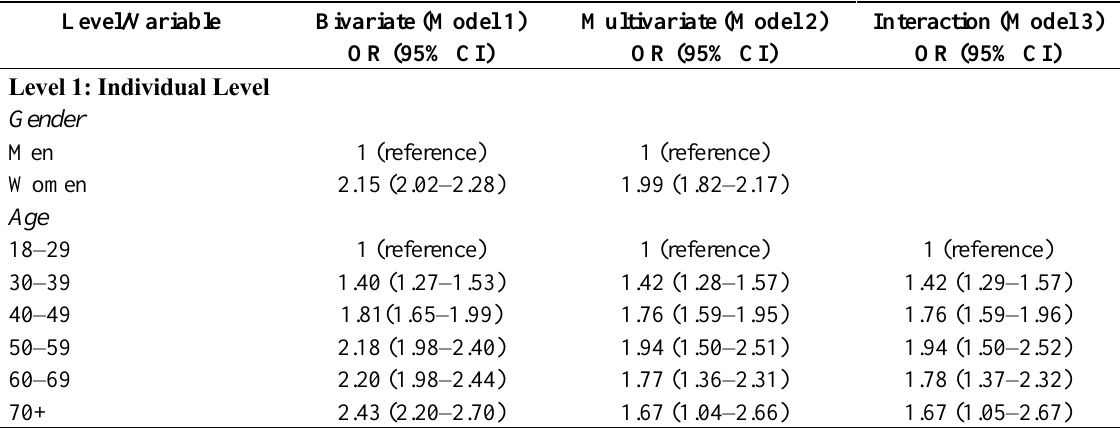
Table 3. ORs and 95% CIs for bivariate, multivariate, and interactive